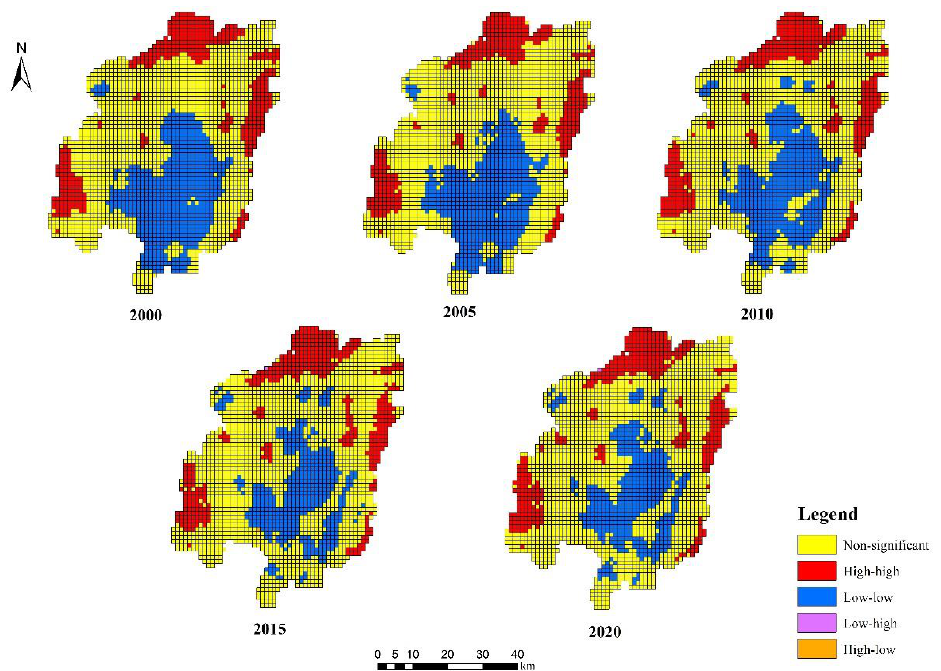
Figure 5. LISA cluster maps of ecological vulnerability in red soil erosion area of Changting from 2000 to 2020. The “high–high” areas represent hot spots of ecological vulnerability, and the “low–low” areas represent the cold spots of ecological vulnerability. The “low–high“ area represents the hot spots near the cold spot of ecological vulnerability, the “high–low“ area represents the cold spots near the hot spot of ecological vulnerability. (“Low–high” and “high–low” area almost do not exist).